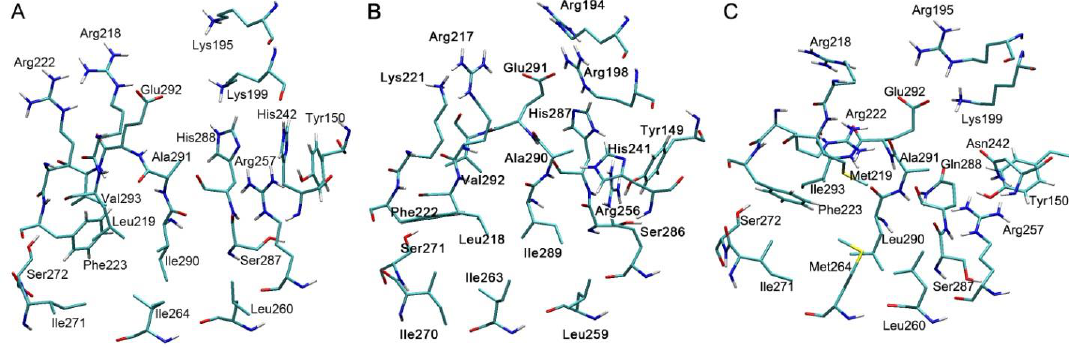
Figure 3. The structures of Sudlow site I of human ( A ), bovine ( B ) and rat ( C ) albumin.